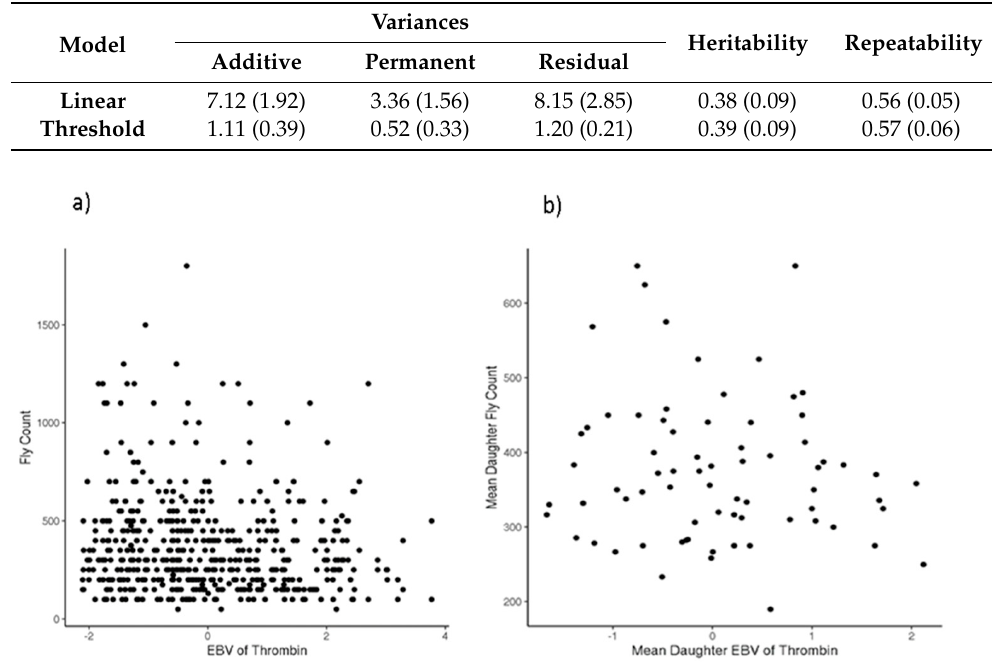
Figure 5. Relationship between fly count and estimated breeding values (EBV) for ( a ) individual animals and ( b ) average of sires’ daughters.